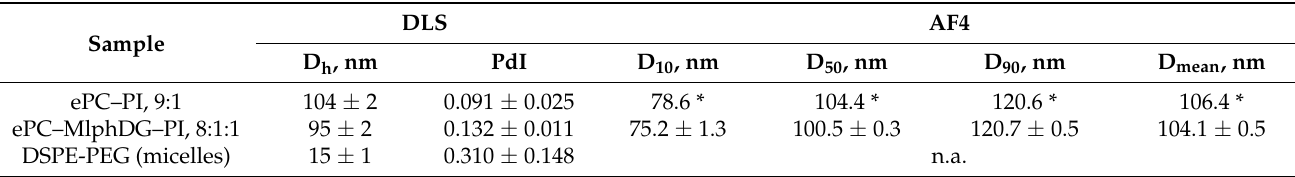
Table 6. Size values by dynamic light scattering (DLS, n = 10) and AF4/multi-angle light scattering (MALS, n = 3).